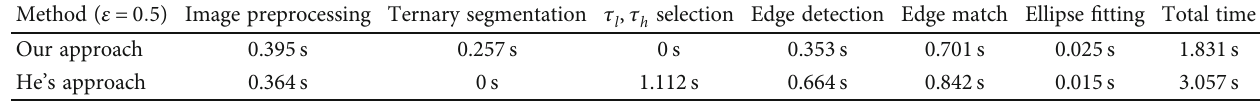
Table 9: Computational cost comparison with He ’ s